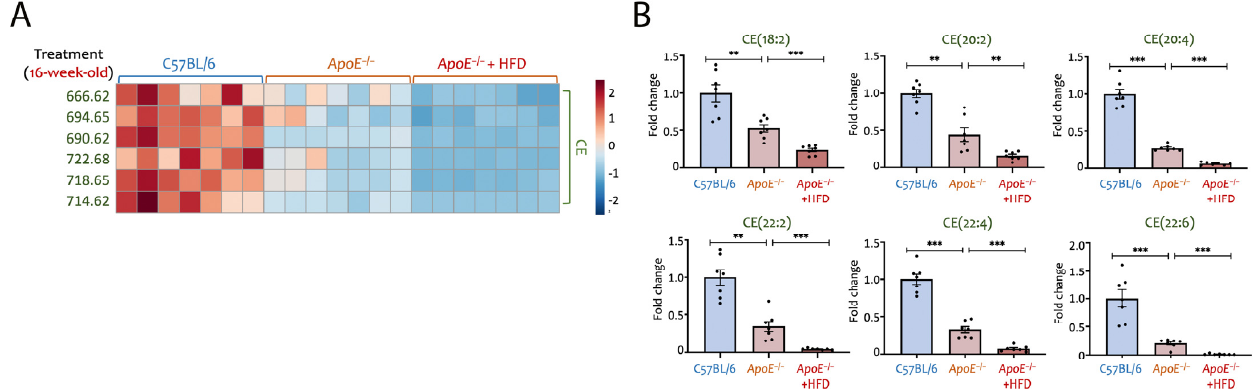
Figure 4. Analysis of cholesteryl ester levels in high-fat diet-fed apoE − / − mice. ( A ) By the exact mass and retention time, CEs were analyzed similarly to other lipid parameters. CE(18:2), CE(20:2), CE(20:4), CE(22:2), CE(22:4), and CE(22:6) were the most abundant CE species in mice. CE levels